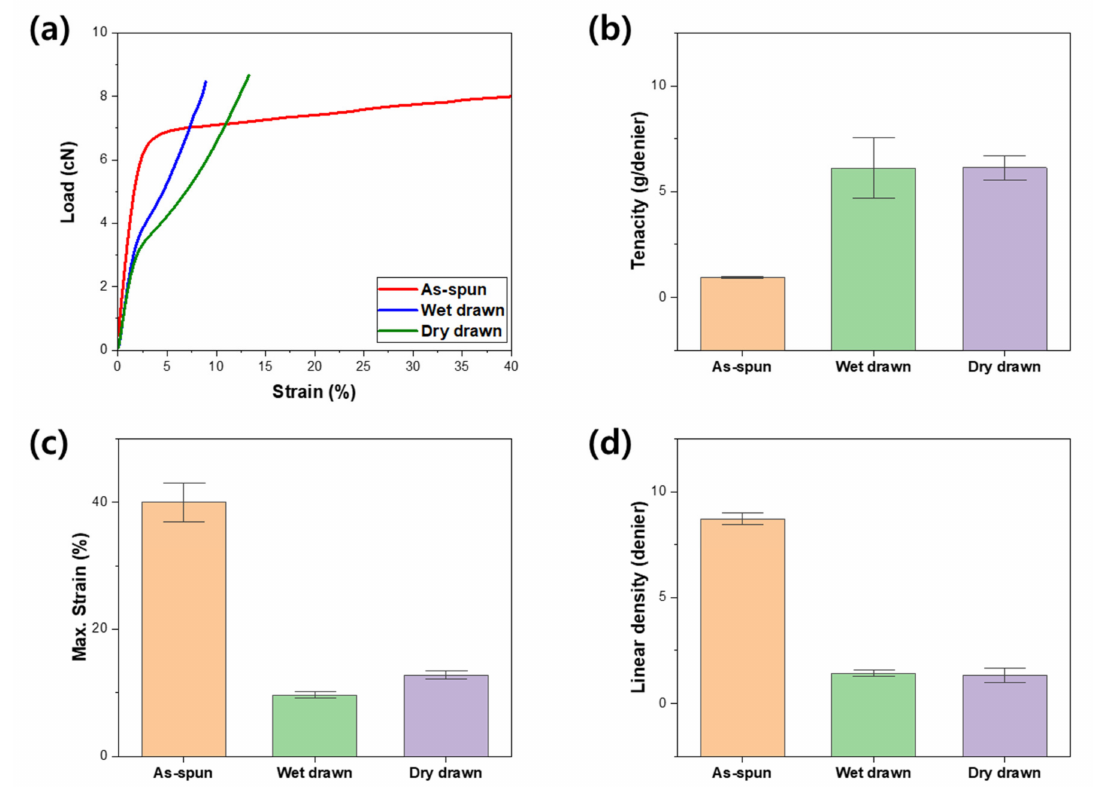
Figure 7. Mechanical behavior of PAN fibers. ( a ) Representative load-strain behavior, ( b ) tenacity, ( c ) maximum strain, and ( d ) linear density of the